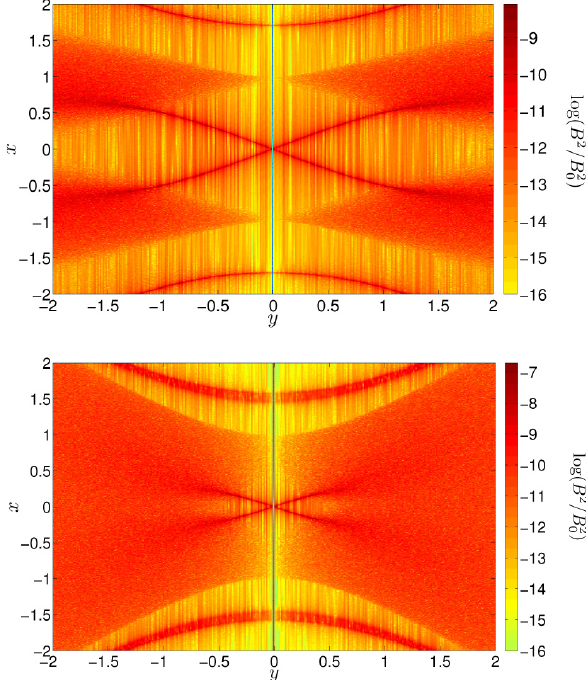
Fig. 18. Power spectrum of transverse magnetic fluctuations from a PIC simulation, for α = 0 . 01, ω p /(cid:127) c = 1. (a) µ = 100, (b) µ = 7.